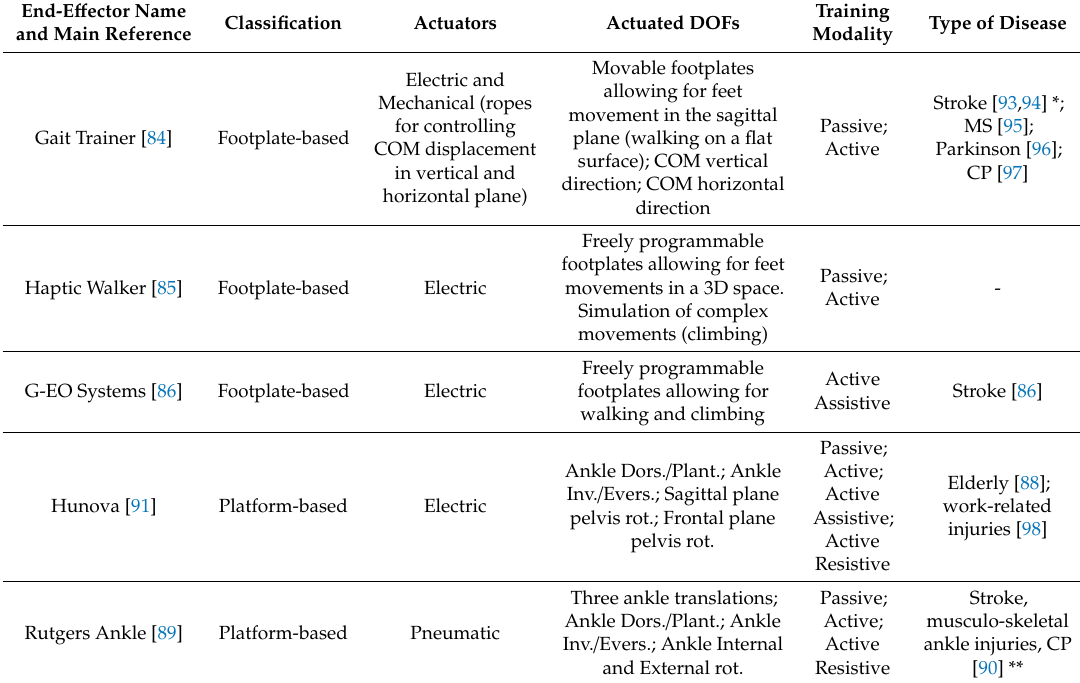
Table 3. Main features of the most common lower limb end-e ff ector rehabilitation